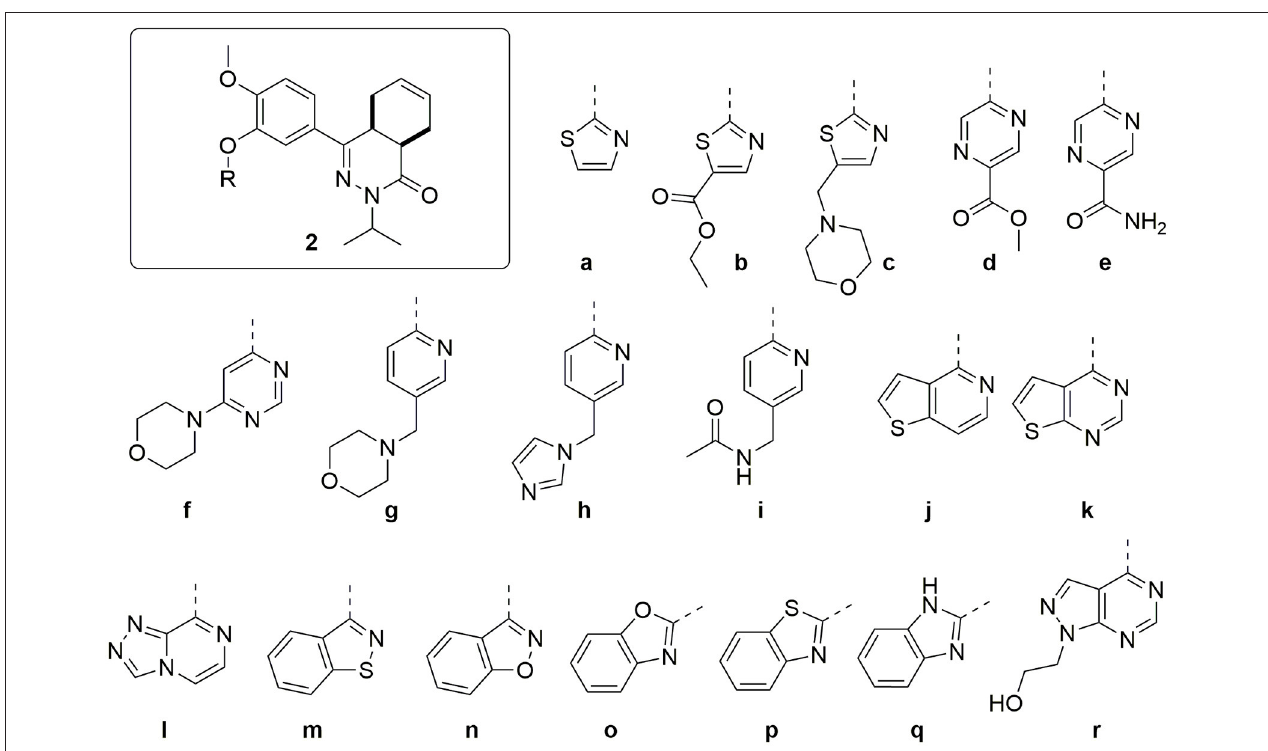
FIGURE 3 | Structures of the selected hits from the virtual screening.